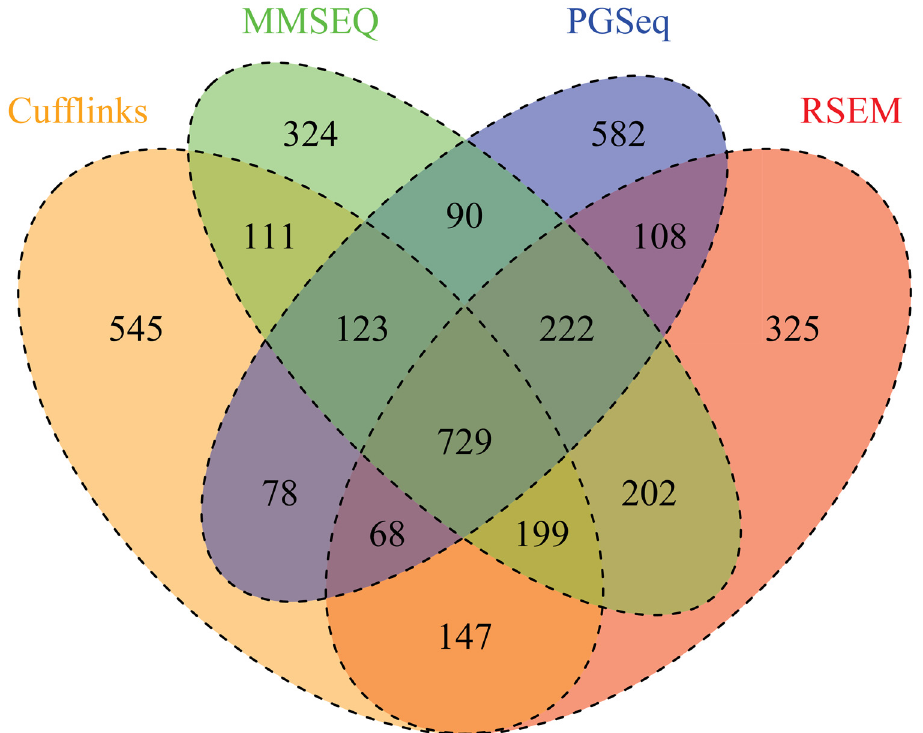
Fig 7. Venn diagram of the significant DE genes for the HDB dataset. The big ovals represent the number of the significant DE genes found by the four methods: Cufflinks, MMSEQ, PGseq and RSEM, which combined with CuffDiff, MMDiff, MMDiff and DESeq, respectively. The overlap of the four ovals in the middle of the diagram is 729, which is the number of the DE genes found by all of the four approaches.